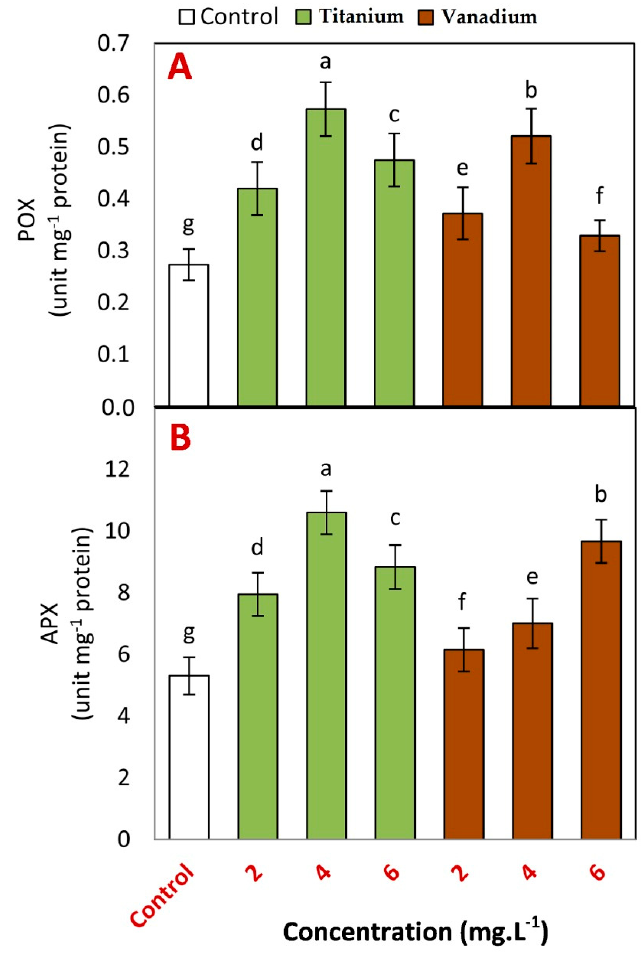
Figure 4. Effect of Ti and V foliar applications on peroxidase ( A ) and ascorbate peroxidase ( B ) activities in red cabbage leaves. The mean values followed by different letter are significantly different at p < 0.05 according to the Duncan test ( n = 3).